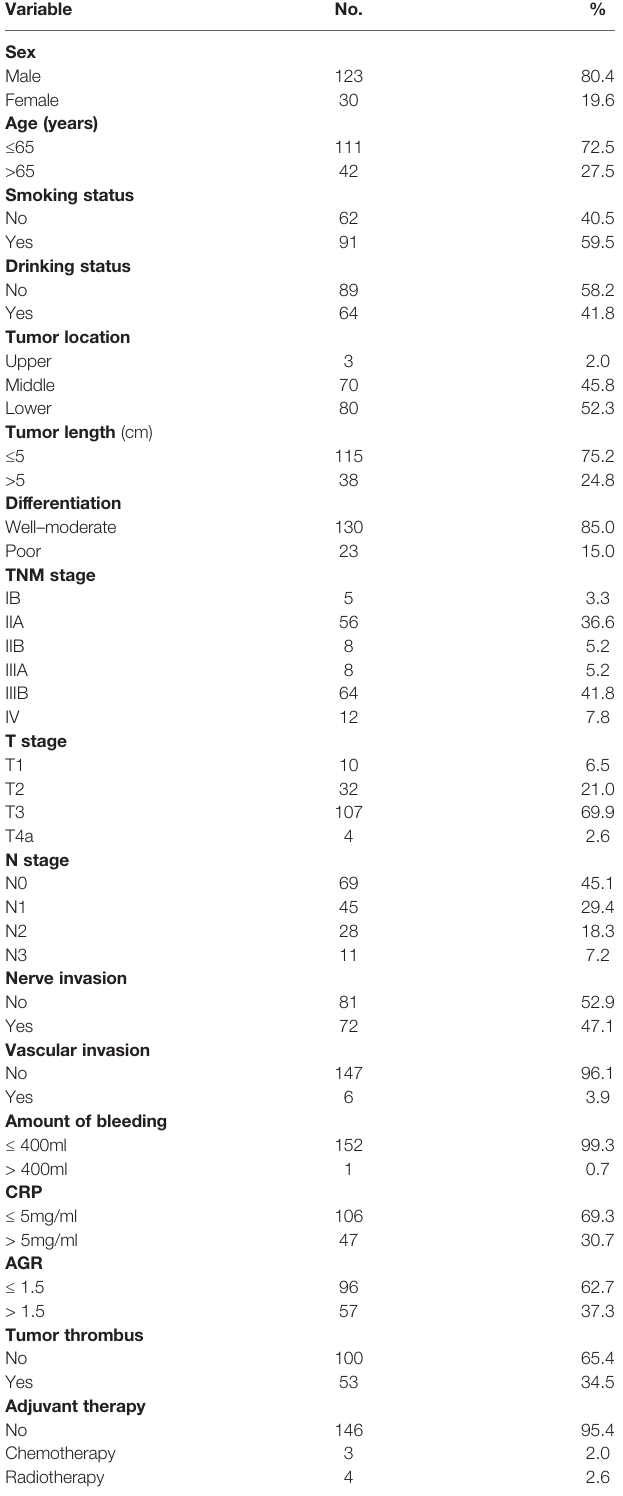
TABLE 1 | The characteristic of clinical information in patients with